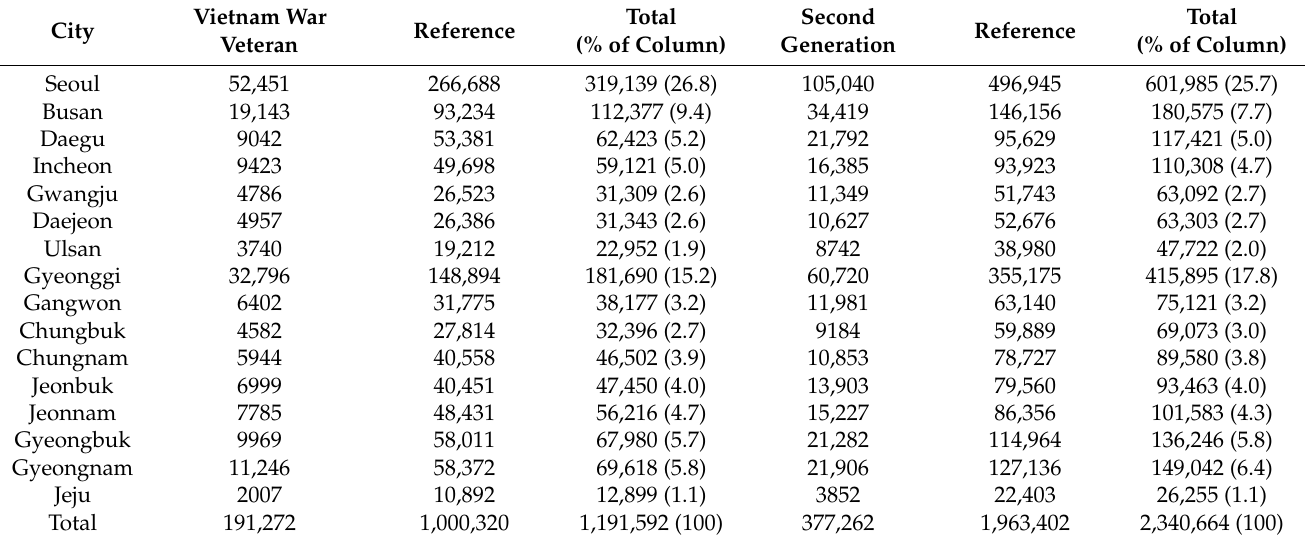
Table 3. Distribution by city of the veteran and second-generation cohort in